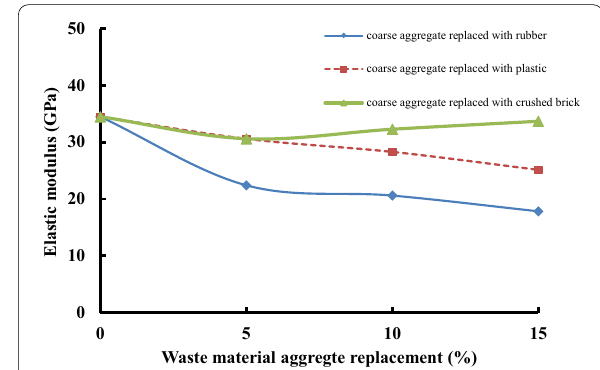
Fig. 8 Splitting tensile strength of concrete with different types of waste material.